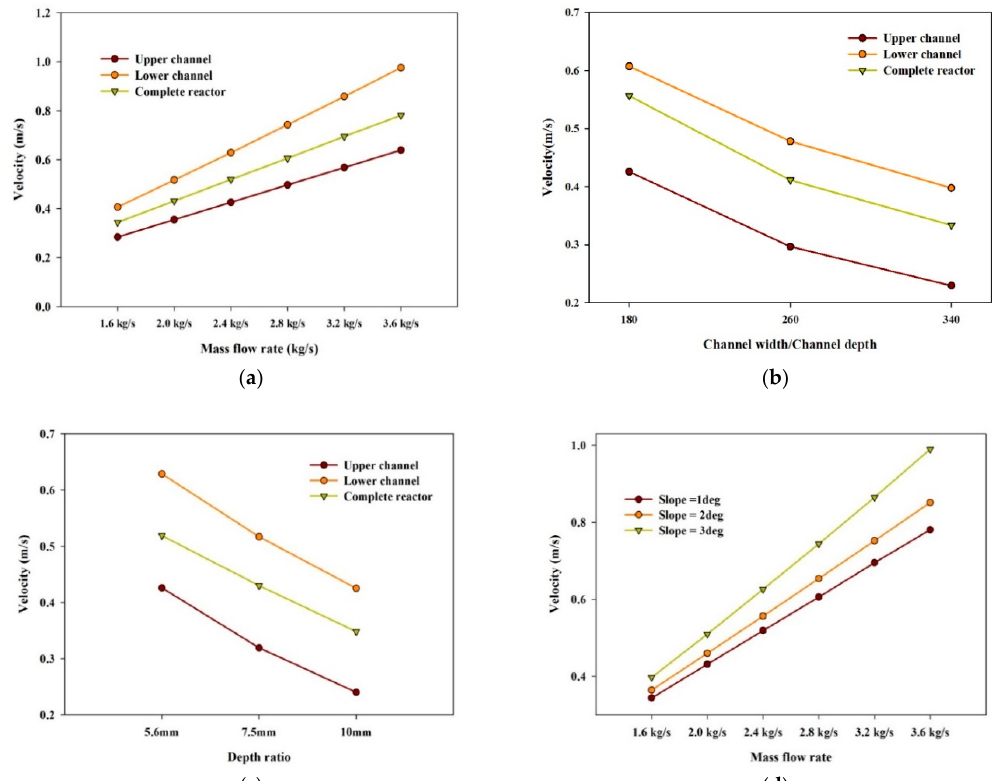
Figure 5. Velocity magnitude ( a ) for different mass flow rates at a water depth of 5.6 mm and slope angle of 2°, ( b ) for various channel width/channel depth ratios at a mass flow rate of 2.4 kg/s and slope angle of 1°, ( c ) for various water depths at a mass flow rate of 2.4 kg/s and slope angle of 1°, and ( d ) for different mass flow rates at a water depth of 5.6 mm and slope angles of 1°, 2°, and 3°. Water depths, channel width, and the velocity of the suspension (i.e., Reynolds number) are the very important parameters for analyzing the fluid pattern in the thin-layer cascade reactor. Velocity contours at constant mass flow rate with the variation in water depth and channel width are presented in Figures 6 and 7. For better visualization, normalized velocity (U/U max ) has been plotted. U (m/s) represents the fluid velocity, and U max (m/s) is the maximum fluid velocity in the reactor.